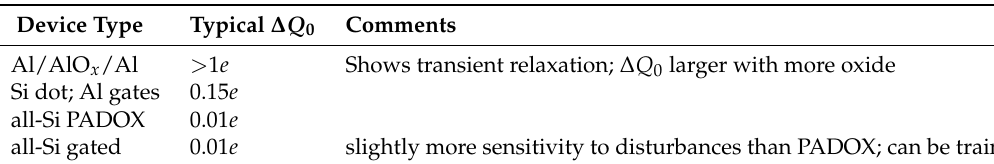
Table 1. Table of typical charge offset drift values for the different device types discussed in this